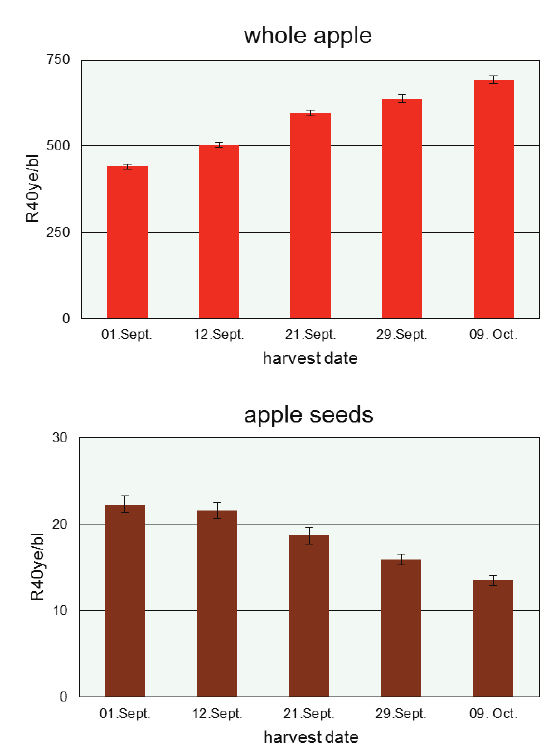
Figure 3: S pectral characteristic emission of leaves (dried crushed nettle leaves), of seeds (whole wheat kernels) and of citric acid. Each bar represents the mean of four measurements of one sample. matrix (Strube and Stolz 2001a)